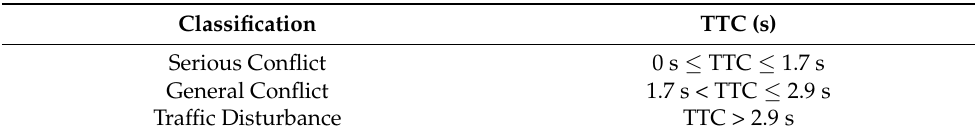
Table 4. Classification of conflict severity thresholds.